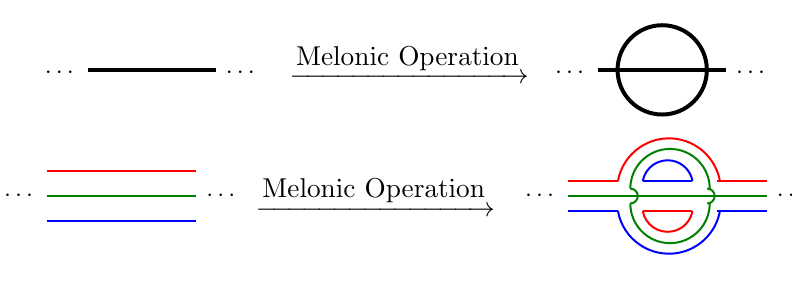
Figure 4. Melonic operation in single line & strand